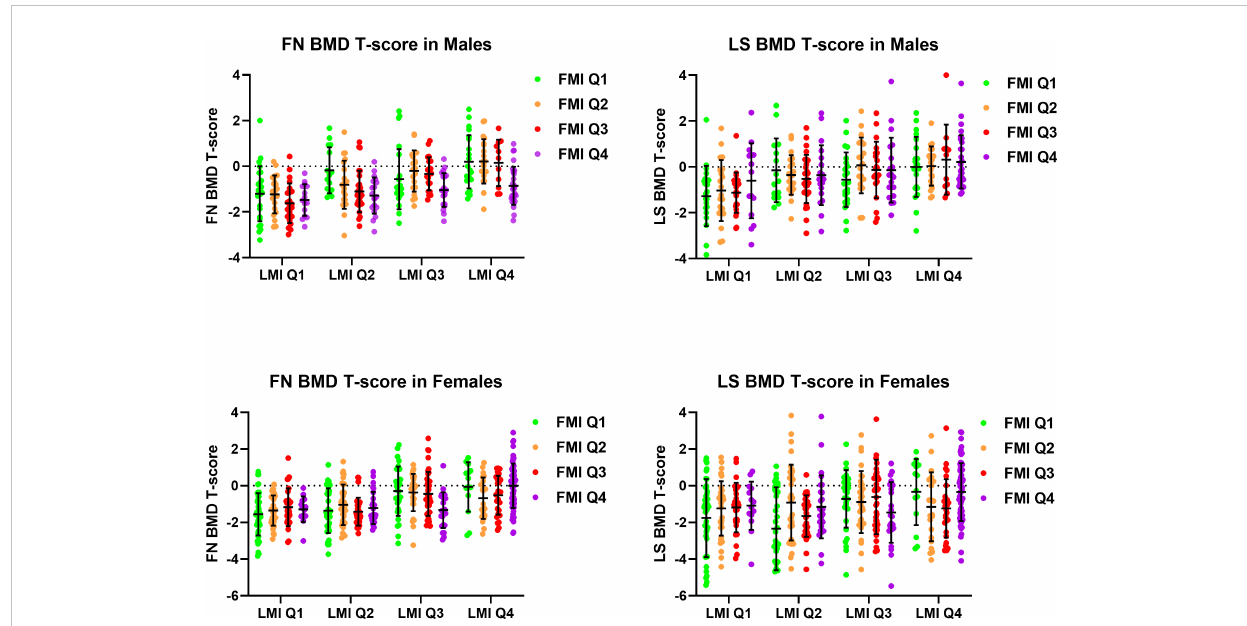
FIGURE 1 Femoral neck and lumbar spine bone mineral density T-score strati fi ed by quartiles of lean mass index and fat mass index in male and female participants. BMD, Bone Mineral Density; FMI, Fat Mass Index; FN, Femoral Neck; LMI, Lean Mass Index; LS, Lumbar